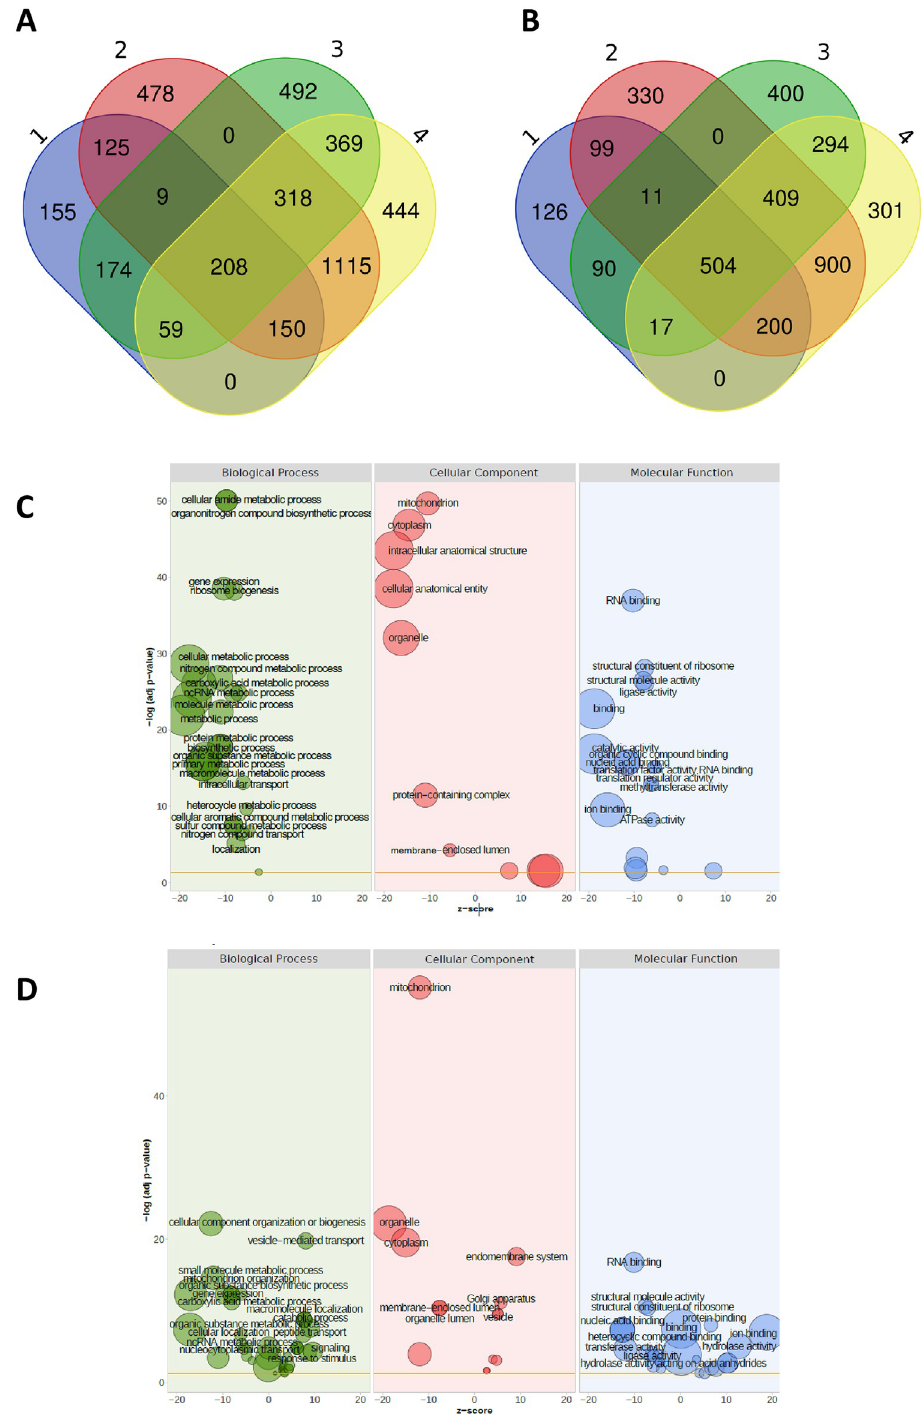
Fig 8. Transcriptional changes due to reduction of TOR1 activity caused by rapamycin treatment as well as by rhe2 gene deletion. Venn diagrams illustrating the number of differentially expressed genes (DEGs) showing upregulation (A) and downregulation (B) in the four different comparisons (see S8A Fig) analyzed. The list of DEGs of each comparison is provided in S3 and S4 Files. Bubble plots displaying enriched GO terms of the DEGs emerging from comparisons 1 (C) and 3 (D) . The x-axis represents the z-score, the y-axis indicates the significance of the term (-log10 adjusted p-value). The area of plotted bubbles is proportional to the number of genes assigned to the GO term.